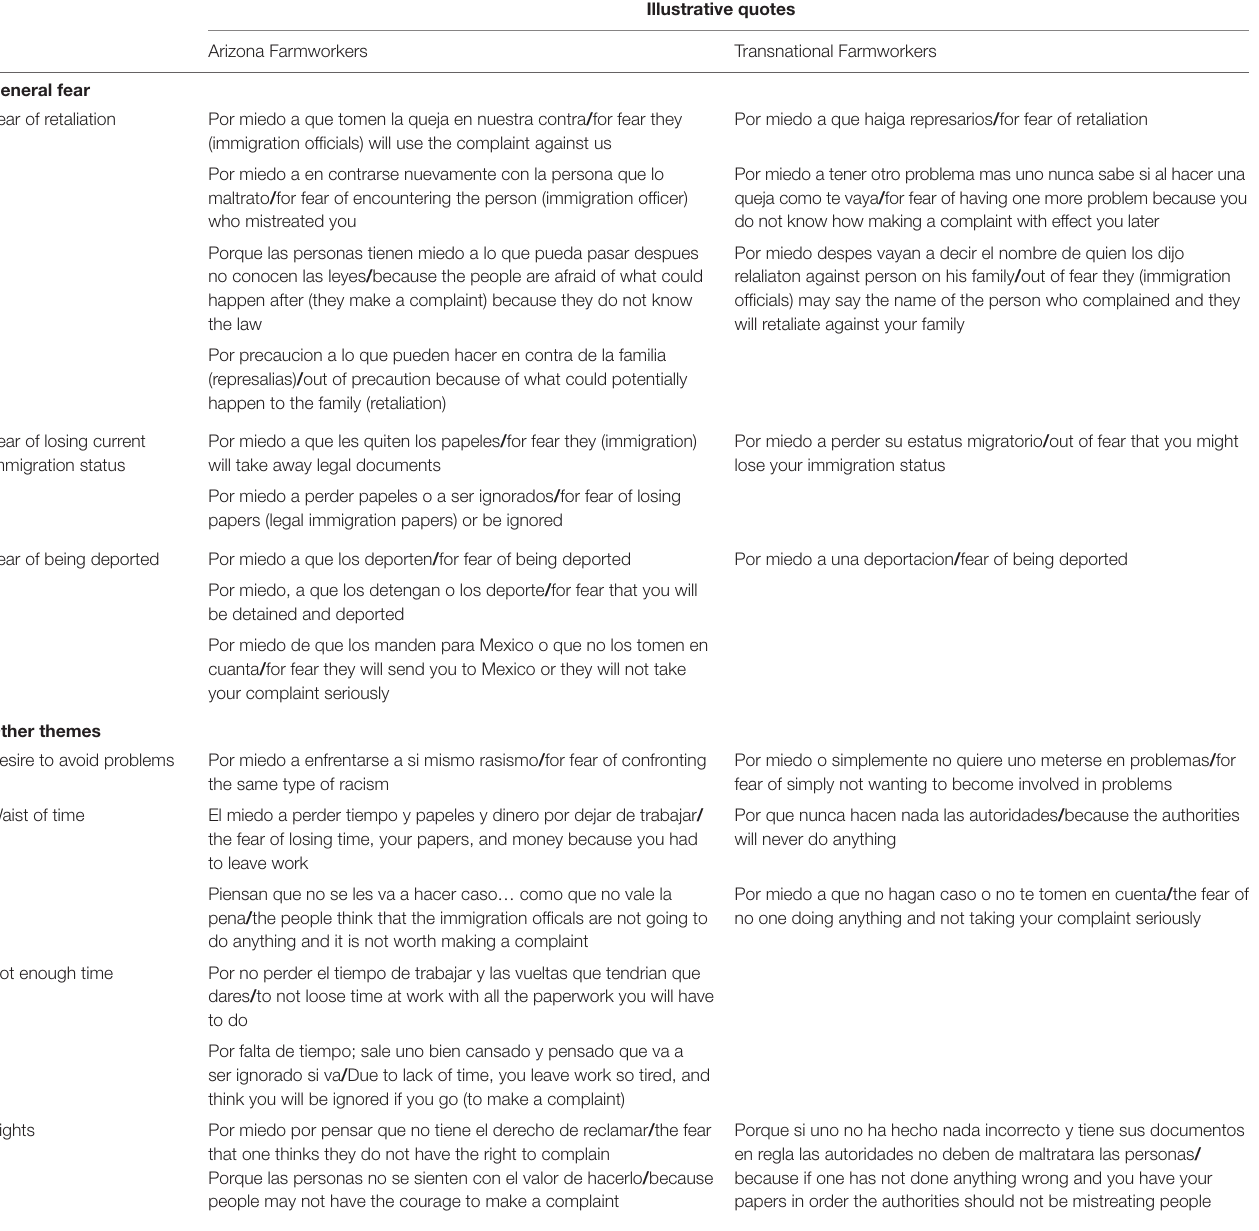
TaBle 4 | summary of reasons not to file a formal complaint of immigration-related mistreatment among arizona and transnational farmworkers of Mexican